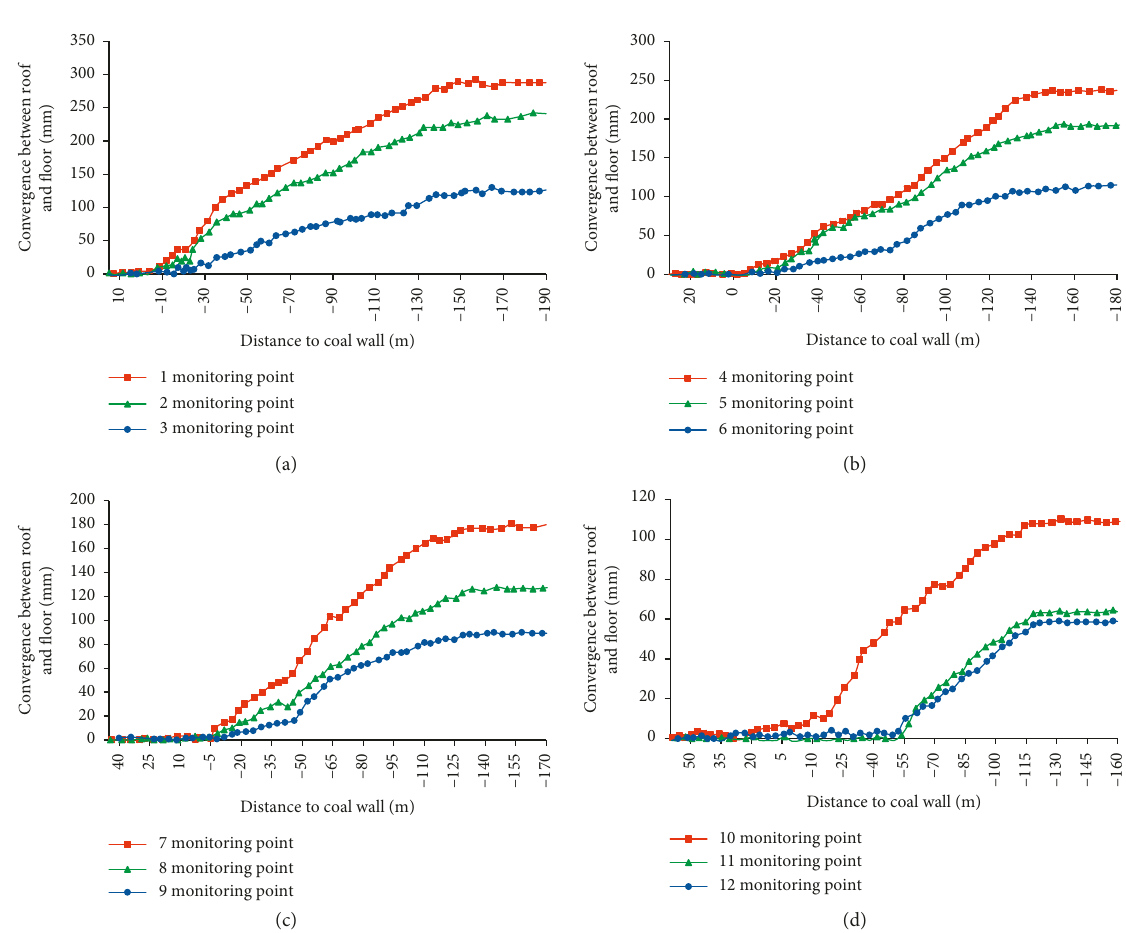
Figure 29: Convergence between the roadway roof and floor as observed from four monitoring stations. (a) I station. (b) II station. (c) III station. (d) IV